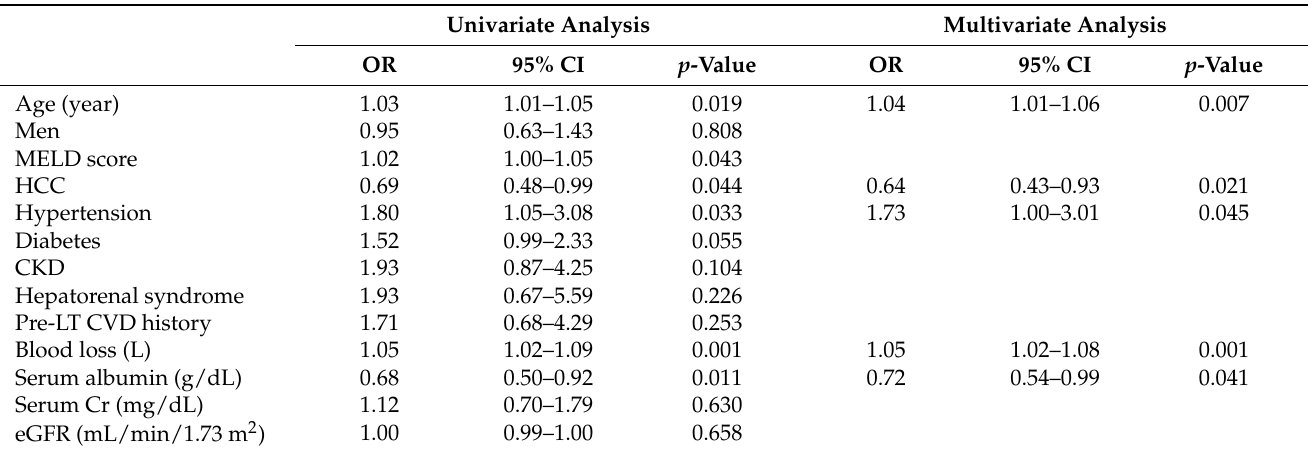
Table 5. Risk Factors of Post-LT AKI after Living Donor Liver Transplantation by Logistic Regression